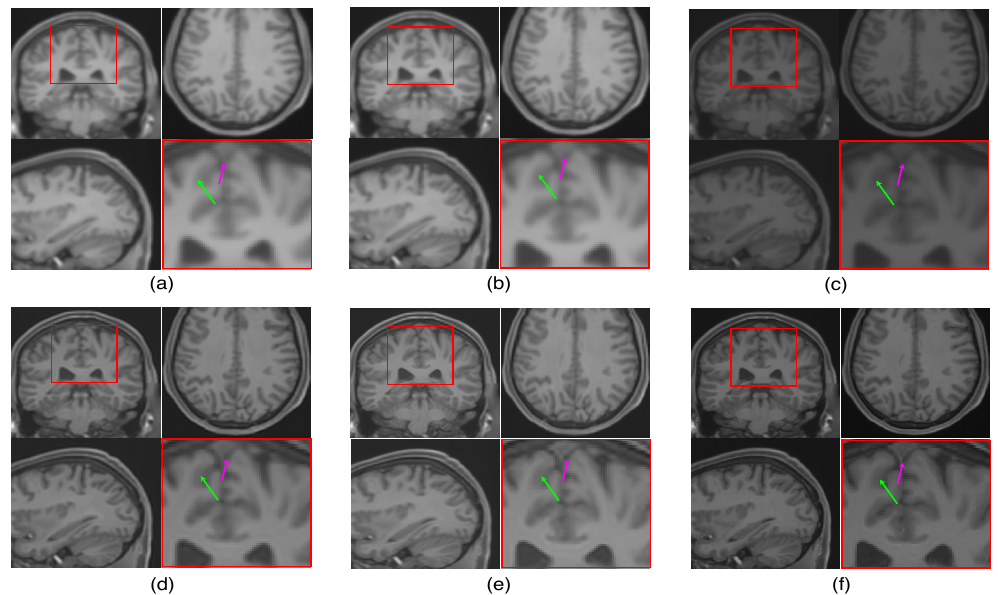
Figure 9. Illustration of reconstruction results for real MR image volume for super-resolution factor 2 using different super-resolution algorithms: ( a ) nearest neighbor interpolation, ( b ) spline interpolation, ( c ) non-local means [13], ( d ) low rank and total variation (LRTV) [12], ( e ) the proposed method, and ( f ) the original denoised high resolution (HR) image. Zoomed version of the red box shown in the axial slice is shown to demonstrate the difference (specifically in tissue boundaries indicated with